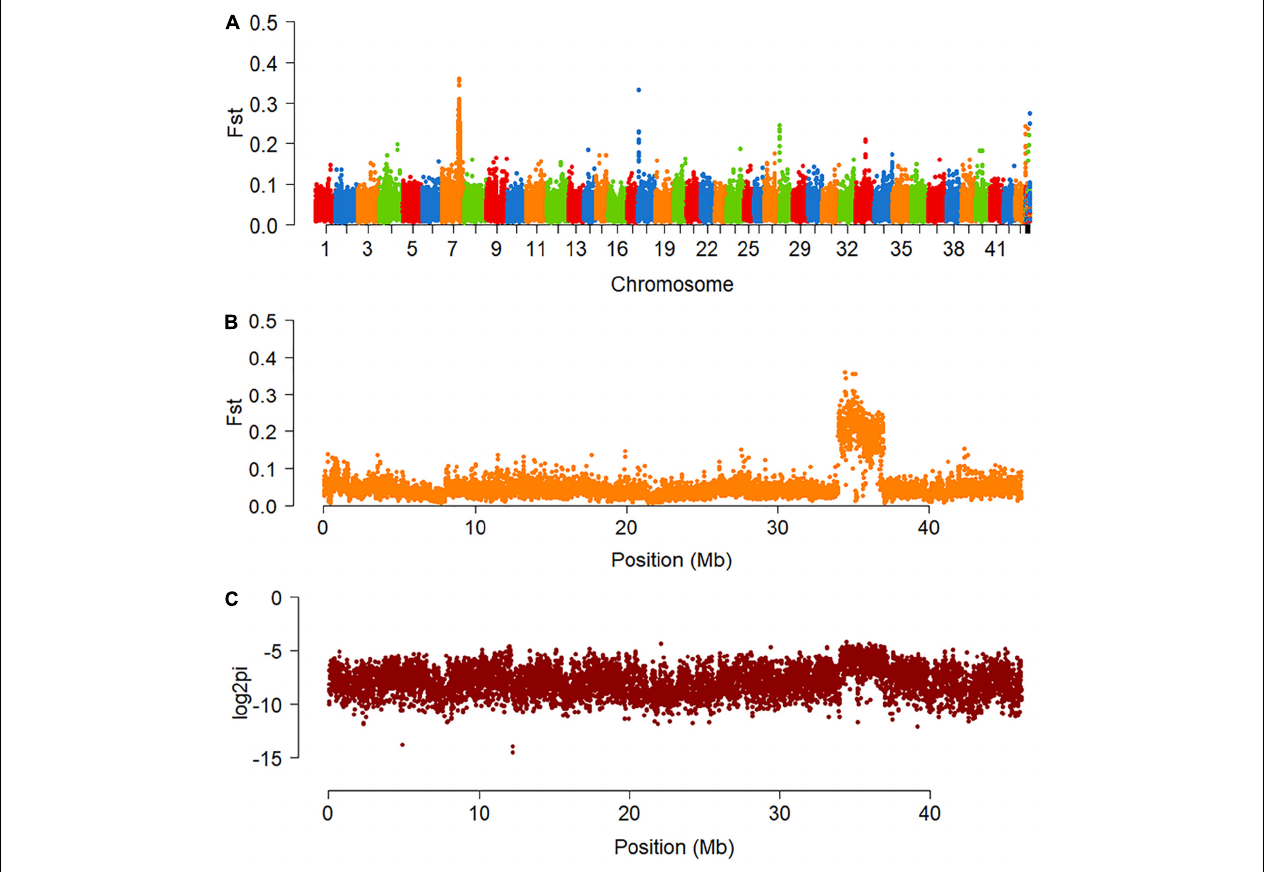
FIGURE 2 | Genomic differentiation of the two sexes of F. chinensis . (A) Genome-wide scan of the fixation index ( F ST ) between the two sexes of F. chinensis . (B) F ST on pseudochromosome Chr7. (C) Nucleotide diversity ( π ) on pseudochromosome Chr7 of the female. Value of π is represented in